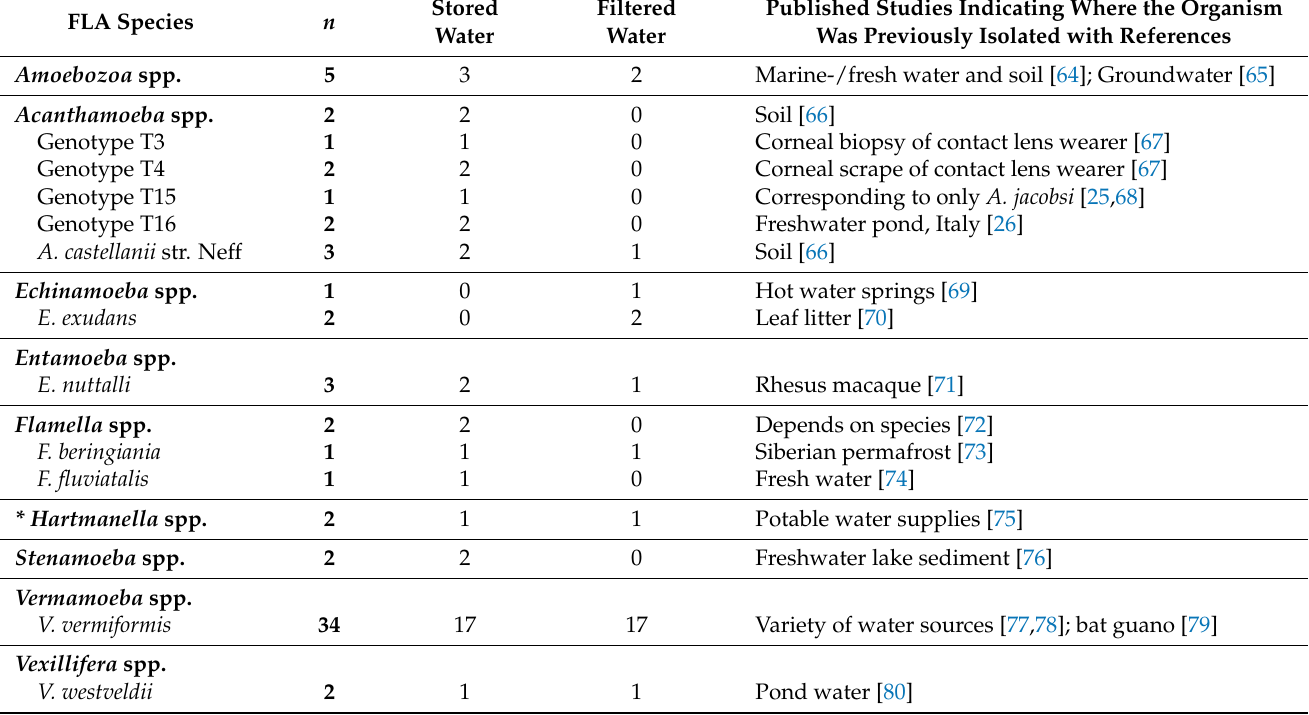
Figure 6. A 1000 × magnification of ( A ) free-living amoebae (FLA) trophozoites; ( B) double-walled Acanthamoeba spp. cysts, and ( C ) Vermamoeba spp. trophozoites. Table 2. FLA isolated and identified from household storage container water and the ceramic pot water sources, and information where the strain has been isolated in other reported studies ( n = total number of samples identified with this